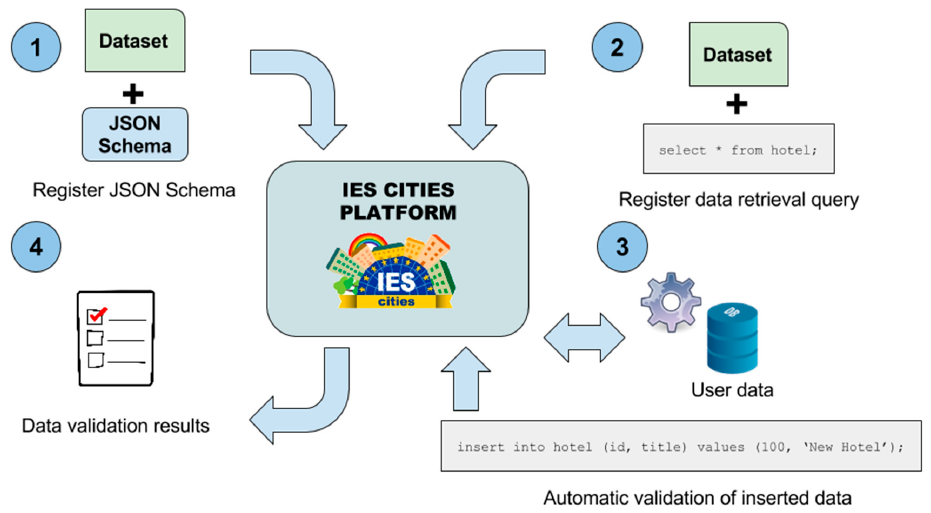
Figure 11. Data validation process in four different steps: (1) JSON schema registration; (2) Data retrieval query; (3) Automatic process; (4) Data validation